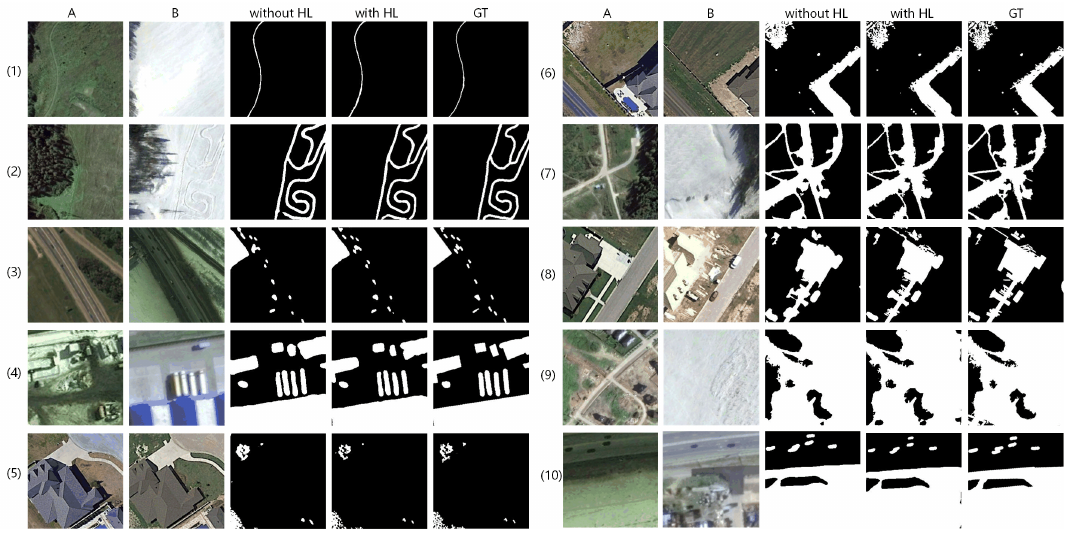
Figure 7. Qualitative comparison of applying hybrid loss